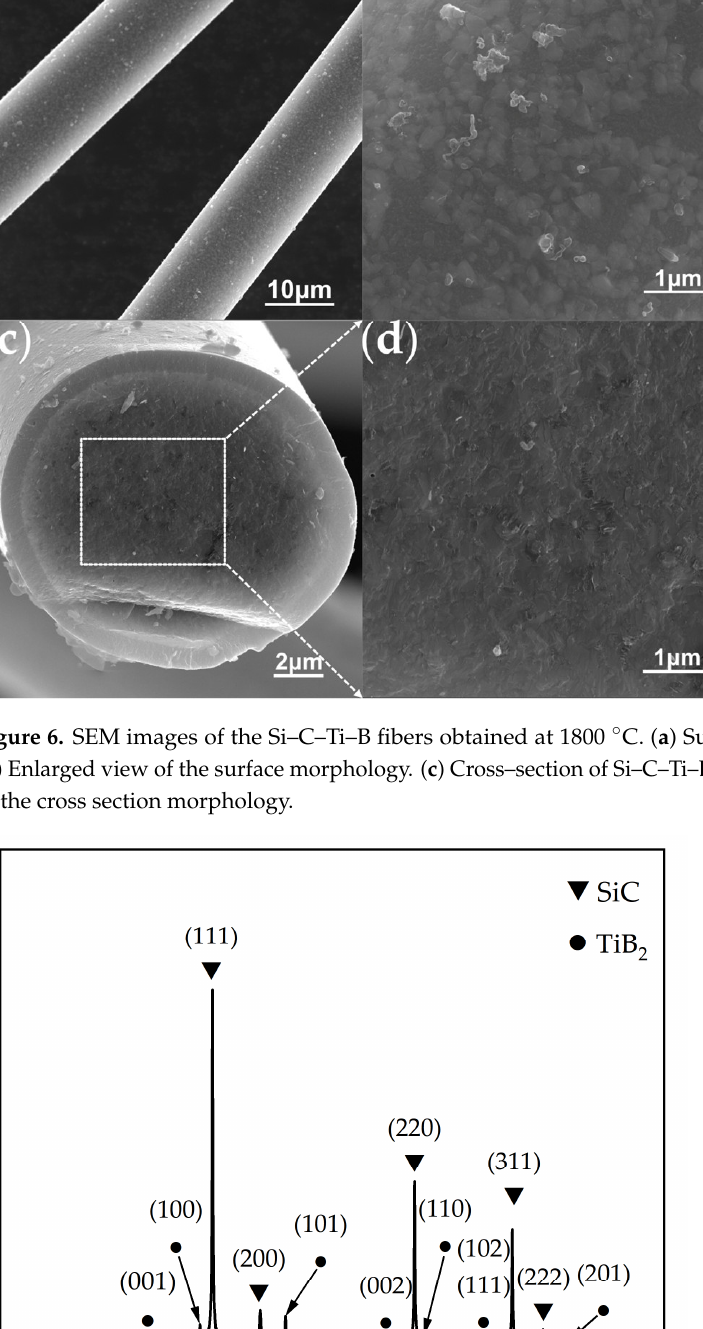
Figure 7. XRD paern of Si−C−Ti−B fibers obtained at 1800 °C.